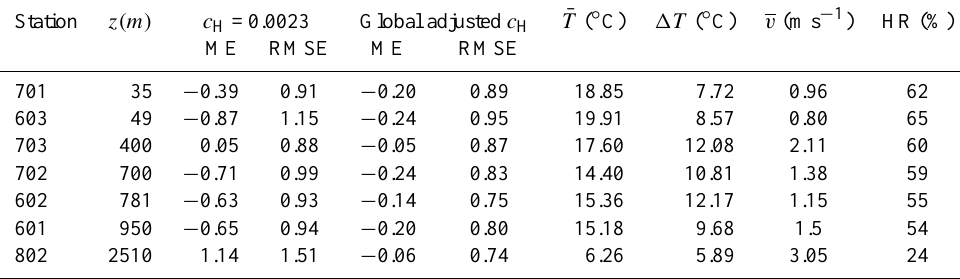
Table 3. Mean error (ME – mmday − 1 ) and root mean squared error (RMSE – mmday − 1 ) with both the constant 0.0023 coefficient and the